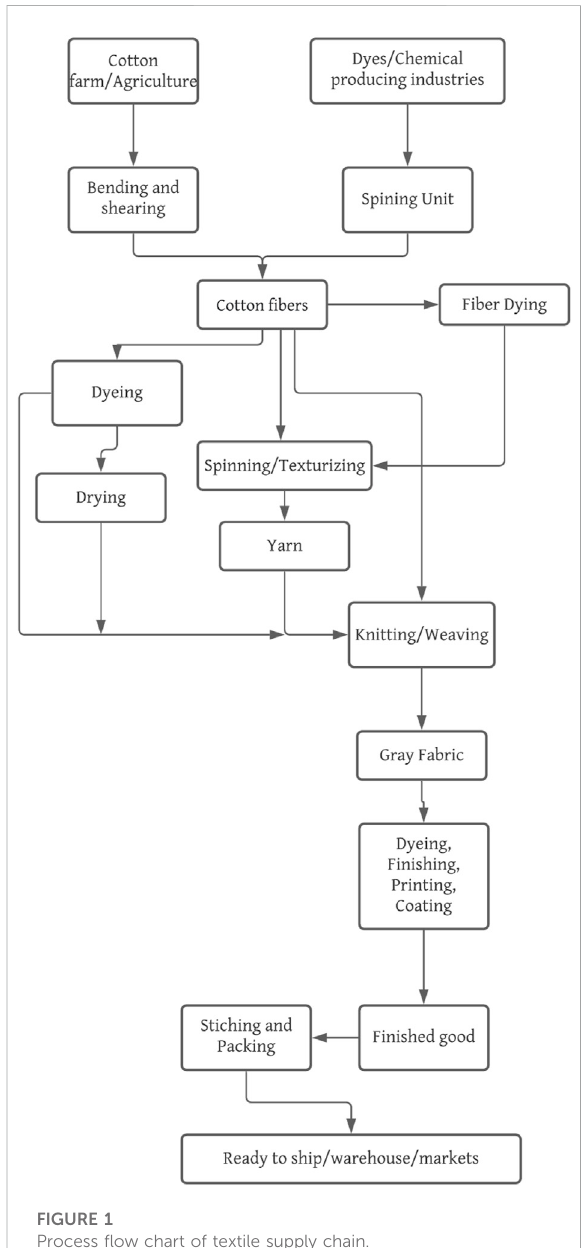
FIGURE 1 Process fl ow chart of textile supply